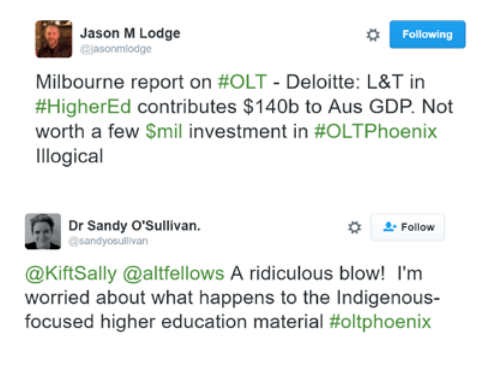
Figure 1: Twitter reacts to OLT